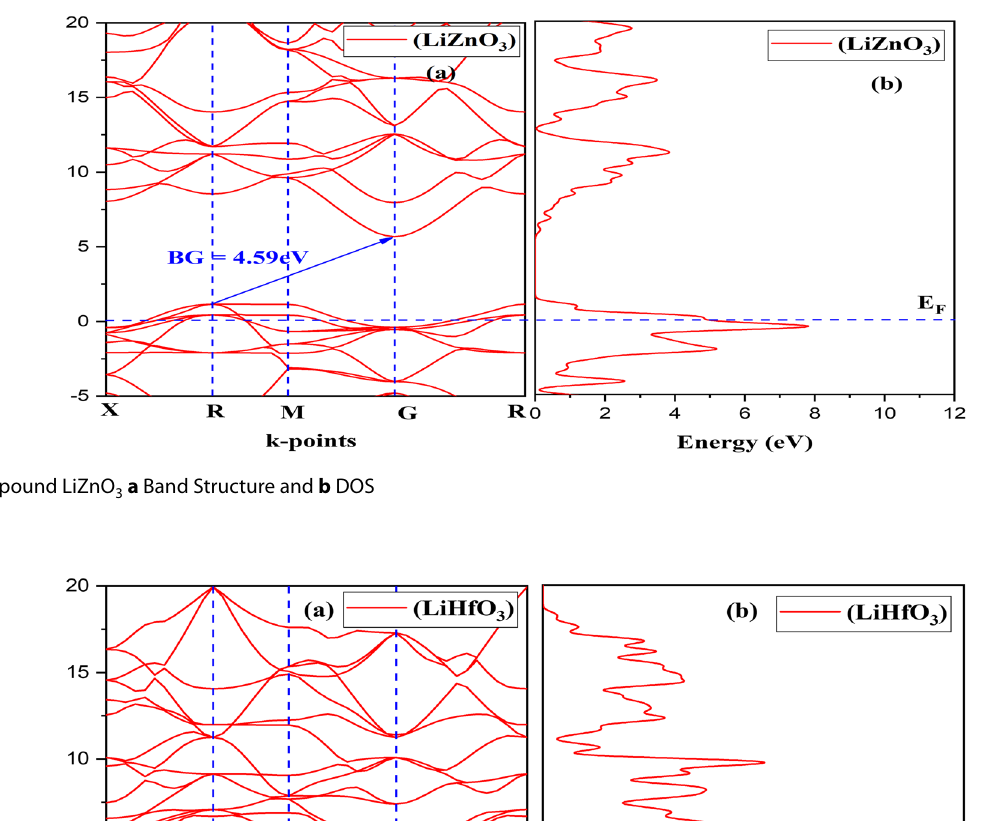
a Band Structure and b 3